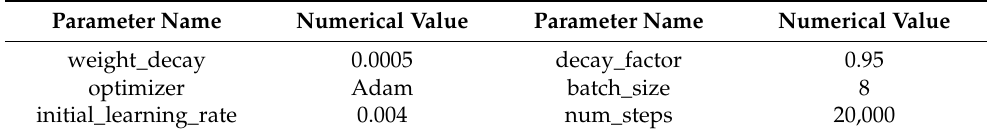
Table 3. Parameter settings of model training.